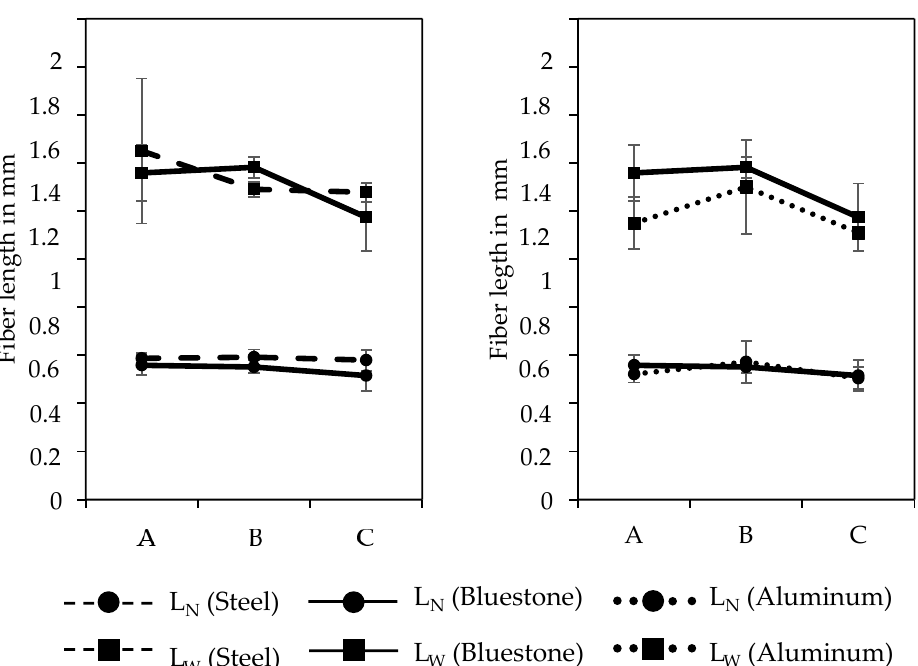
Figure A5. Fiber length (N = number average; W = weight or length average) for different tool types (for better representation in two diagrams) with 20 wt.% nominal fiber content at different specimen locations A, B, and C in accordance with Figure 7.